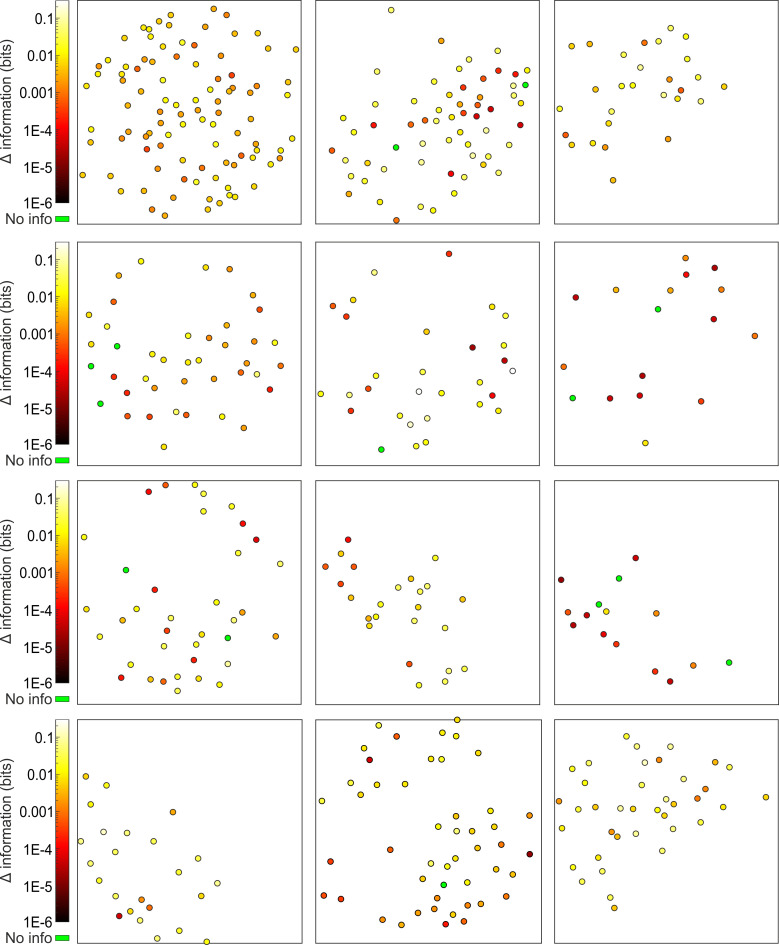
Cell-specific encoding of behavioral state-dependent information in distributed VPM subnetworks.Spatial map of neurons encoding whisking information in 12 out of the total 24 analyzed time series. The pseudocolor scale shows significantly informative neurons (see Materials and methods).